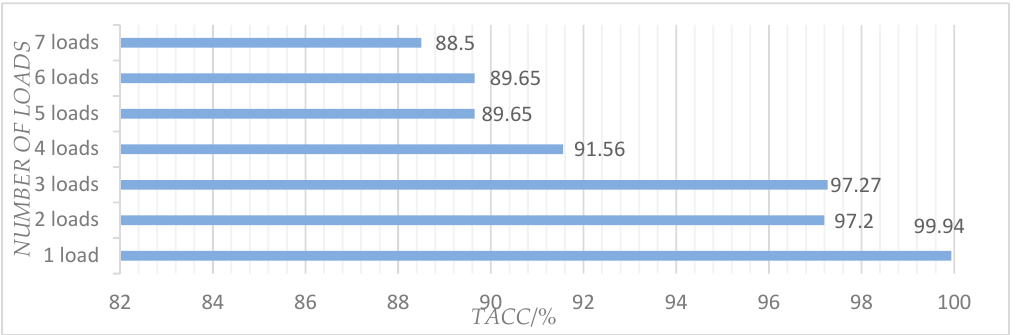
Figure 9. Each test total loads’ accuracy in REDD house 2.